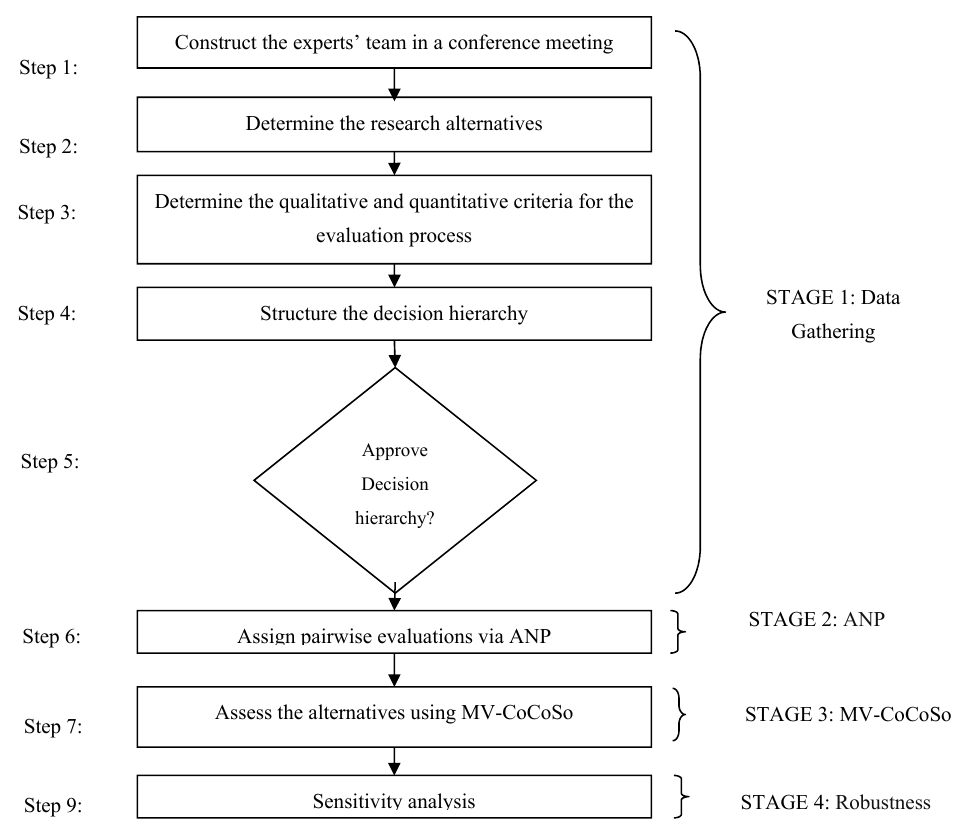
Figure 1. Schematic representation of research methodology for assessing the natural hazards of 97 Tehran. 98